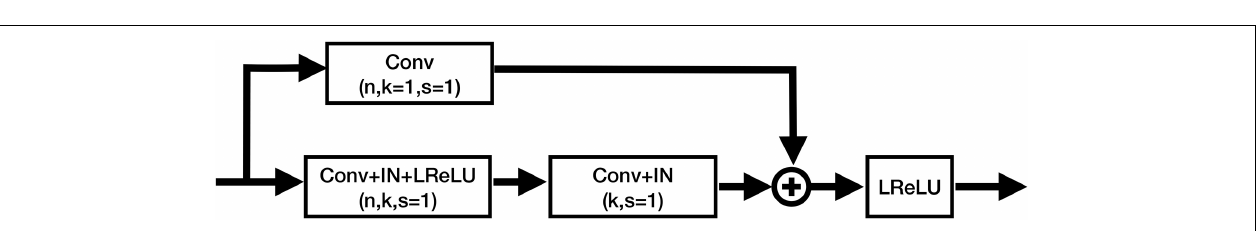
FIGURE 2 | The architecture of our proposed CAU-NET. The red arrows denote maxpooling, and the blue arrows denote the transposed convolution. The black arrows denote the copying of feature maps. “Concat” denotes the channel-wise concatenation. “ResBlk” denotes the residual block, whose structure is shown in Figure 3 .